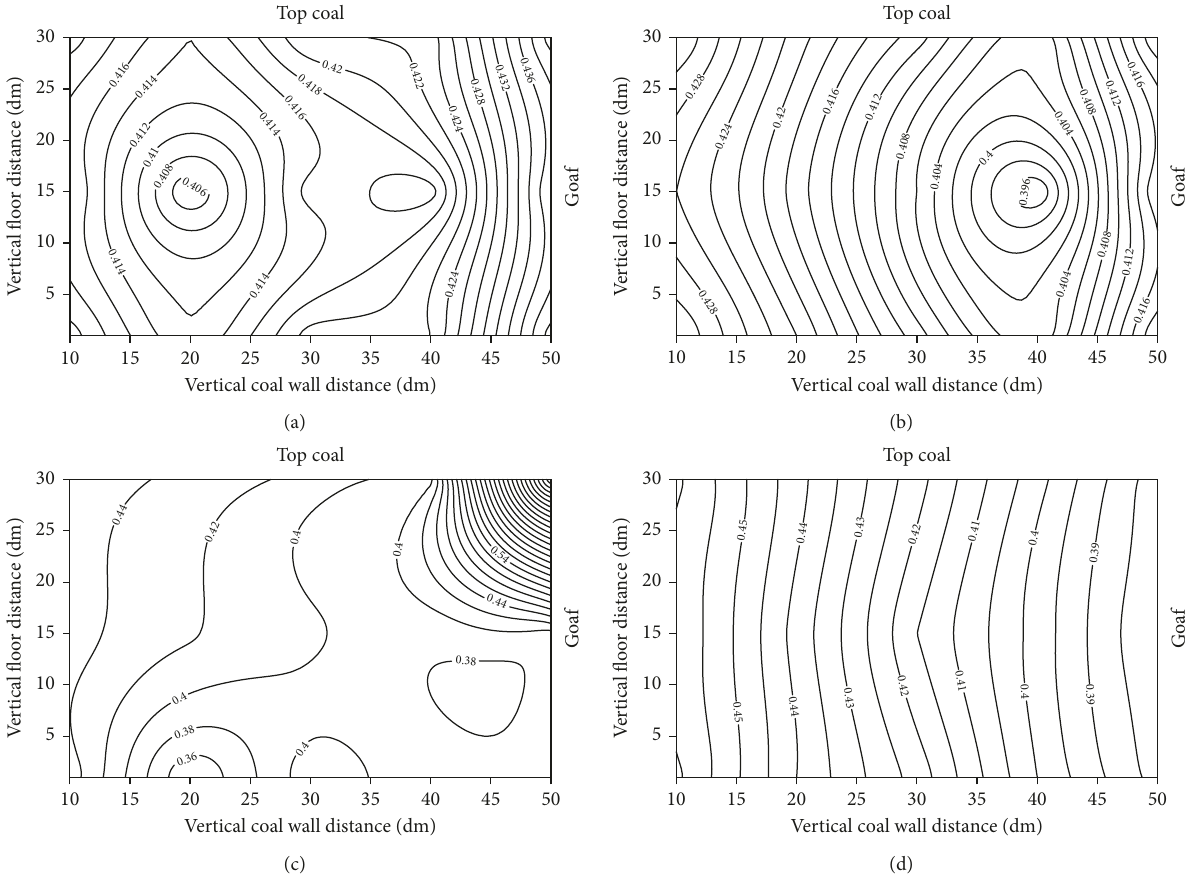
Figure 4: Isograms of gas volume fraction at sections of the face. (a) #15 support measurement section. (b) #55 support measurement section. (c) #95 support measurement section. (d) #105 support measurement